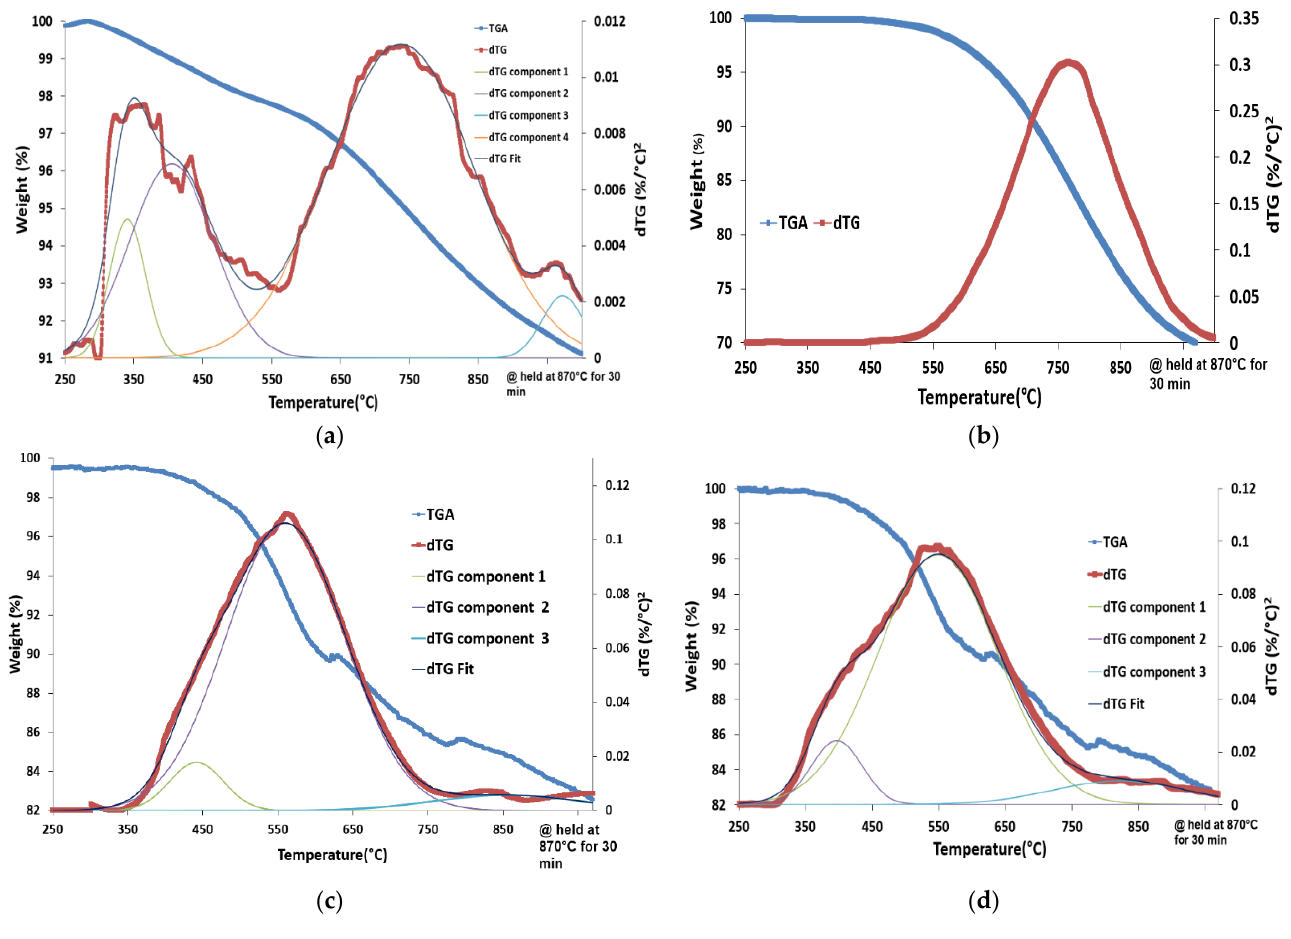
Figure 9. TGA-DTA thermograms for LSF ( a ), Fe 2 O 3 ( b ) CS-4 ( c ), CS-5 ( d ). The amounts of reacted hydrogen as a function of temperature obtained by integration of intervals in Figure 8 are depicted in Figure 10. More than 60% of oxygen in Fe 2 O 3 reacted at 580 ◦ C. At lower and higher temperatures, the reacted oxygen is less than 20%, respectively. In LSF, it increased almost linearly between 300 and 750 ◦ C. The core for CS-4 with partial coverage of LSF (Figure 10a). On the other hand, the distribution of oxygen for CS-5 with high degree of core coverage resembled pure LSF (Figure 10b).